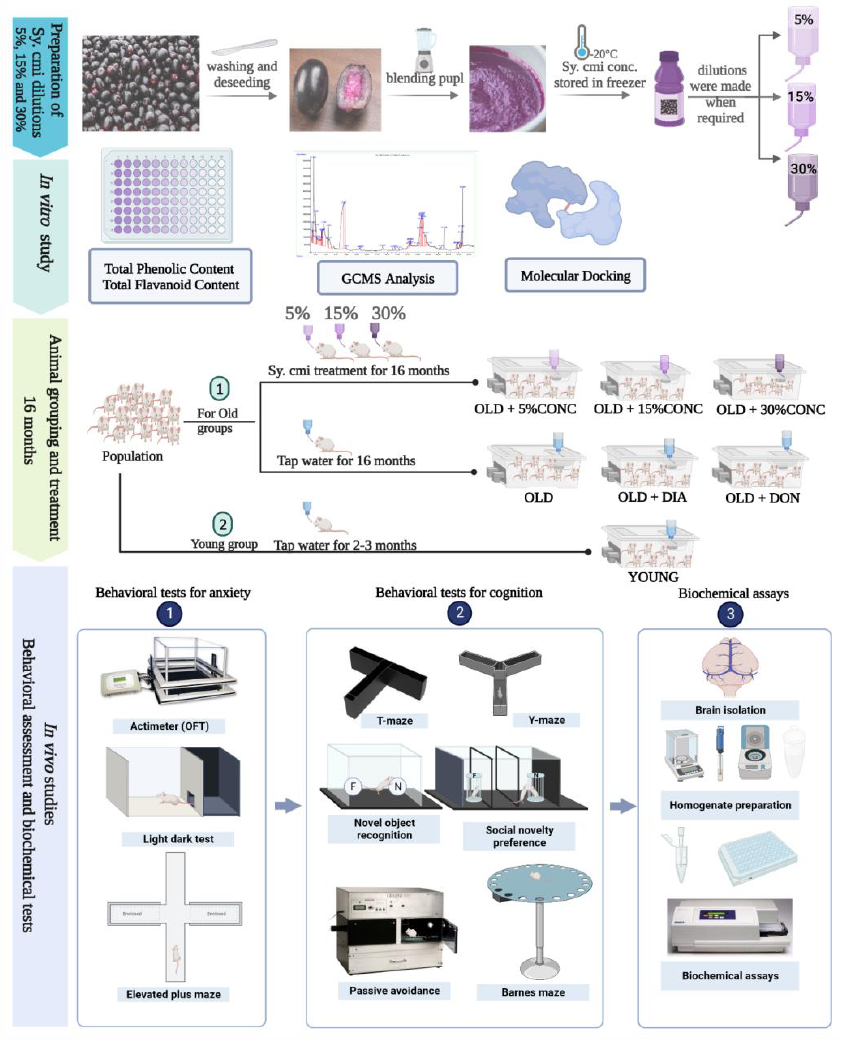
Figure 1. Experimental layout including preparation of Sy. cmi pulp dilutions with in vitro total phenols/flavonoids and Gas Chromatography-Mass Spectrometry (GC-MS)analysis. The illustrative depiction of animals grouping and supplementation with Sy. cmi dilutions for 16 months with subsequent neurobehavioral experimentation to evaluate the impact of Sy. cmi on (1) anxiety-like behavior and (2) age-related amnesia in mice followed by (3) biochemical analysis of isolated brains. Created with BioRender.com (XZ24R43BN4; accessed on 11 December 2022).